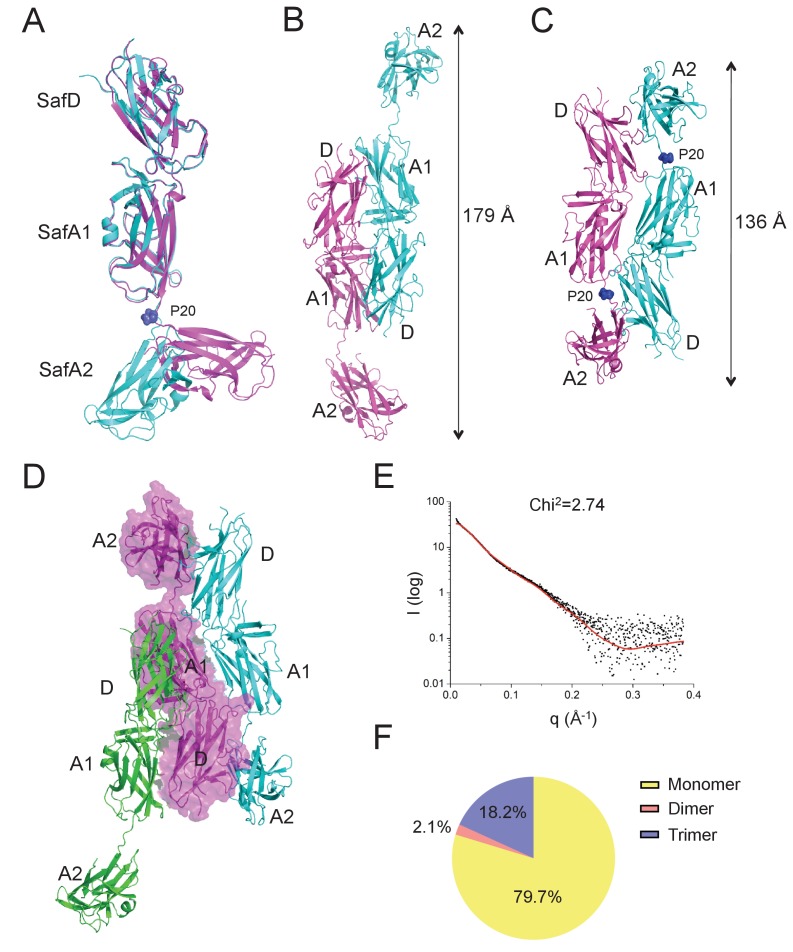
Self-associating SafDAA-SafDAA interaction.(A) The superimposition between ‘I'- and ‘L’-like SafDAA-dsc. The two molecules are colored in cyan and magenta, respectively. The Pro20 residue in the linker LoopG-A between SafA1 and SafA2 is highlighted with sphere representation and colored in blue. (B) The Type I dimerization. SafD-SafA1 (molecule 1, magenta) interacts with a nerighbouring counterpart (molecule 2, cyan) in a head-to-tail configuration. The overall length of the Type I dimer is 179 Å. (C) The Type II dimerization. Two SafDAA molecules intertwine with each other, enabling the intermolecular interaction between SafD (molecule 1, magenta) and SafA2 (molecule 2, cyan). As a result, the dimerization appears to give rise to a more intimate ‘6–9’-like self-association. The overall length of Type II dimer is 136 Å. (D) The SafDAA trimer. For the purpose of clarity, the SafDAA molecule in the middle is shown with transparent surface and the other two are shown in cartoon representations. (E) The SAXS characterization. Black line, experimental data. Red line, the theoretical scattering pattern derived from SafDAA multimers. (F) Oligomeric distribution estimated by SAXS analysis.10.7554/eLife.28619.015Figure 5—source data 1.Source data for Figure 5E.SAXS data were recorded a X-ray beam with the wavelength of 1.03 Å (BL19U2, SSRF, China).